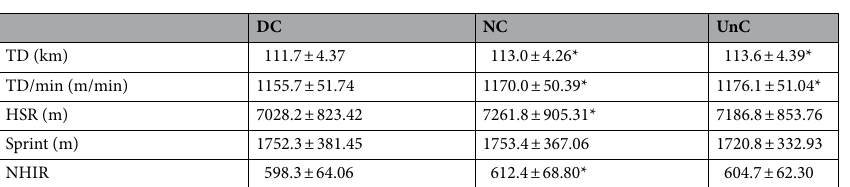
Table 1. Comparison of the physical match performance of the teams led by coaches who are going to be dismissed (DC), new coaches (NC) and unchanged coaches (UnC). *Significantly different from DC. TD total distance, TD/min relative total distance, HSR high-speed running distance, NHIR number of high-intensity runs.